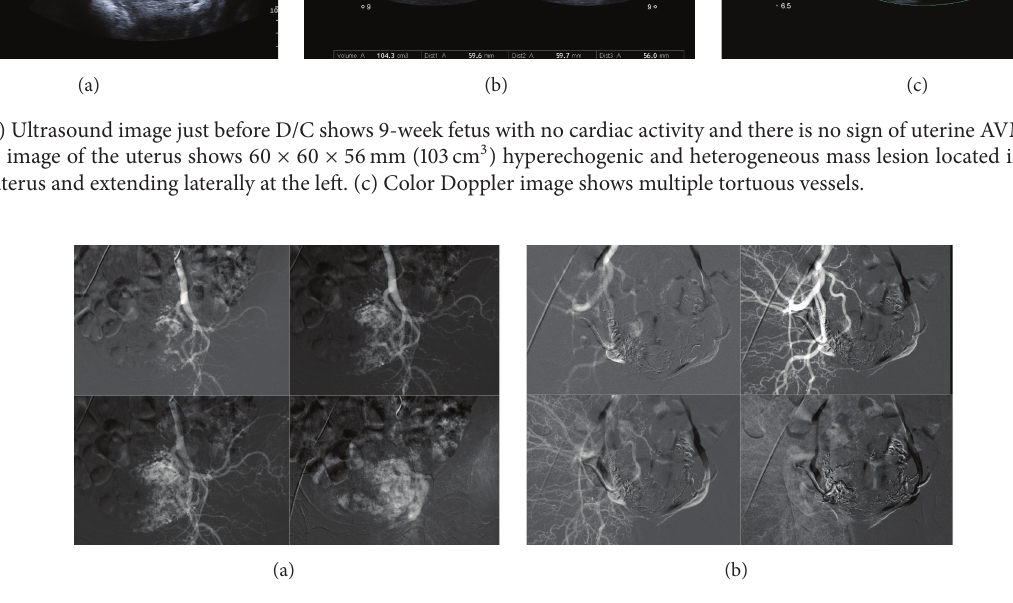
Figure 2: (a) Right/left internal iliac uterine artery angiography showing opacification of a slightly enlarged right uterine artery and hypervascular mass in the uterus. (b) Postembolization angiographic